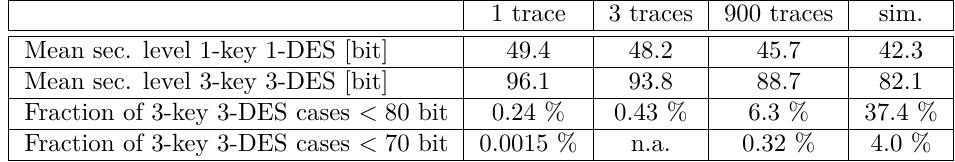
Table 3: Security levels for 3-key triple-DES based on measured single DES results, and simulation without additive